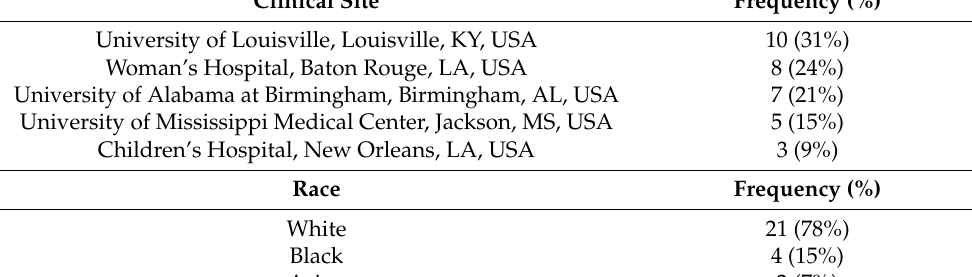
Table 1. Demographic information for non-genetics neonatology providers participating in SouthSeq. Clinical